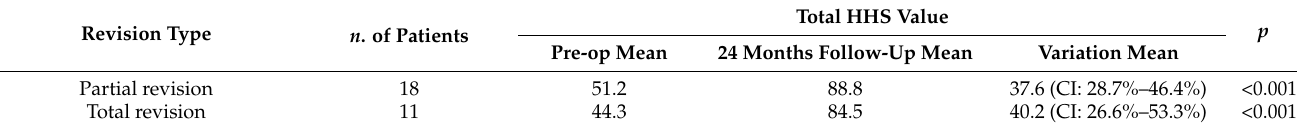
Table 7. Total HHS pre-op vs 24 months’ follow-up values in subgroups of revision type.